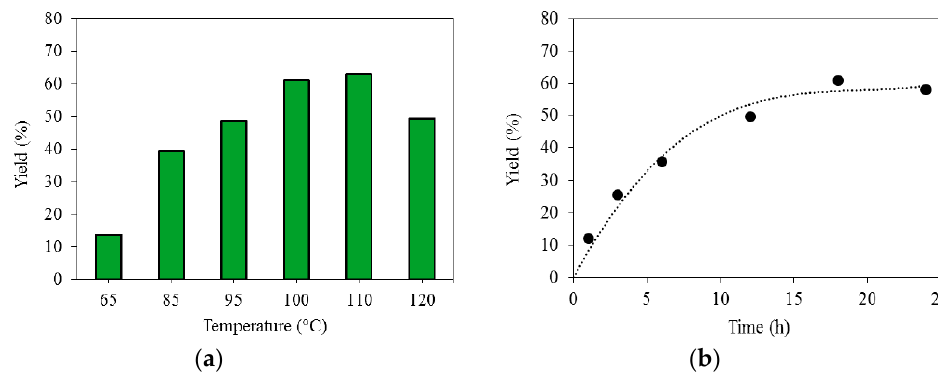
Figure 2. Effect of temperature ( a ) and reaction time ( b ) on the yield of 4,4-dimethyl- γ -butyrolactone formed by cyclocarbonylation of 2-methyl-3-buten-2-ol. Reaction conditions: 0.1 M 2-methyl-3-buten-2-ol, 4 mol% Pd(OAc) 2 , 16 mol% DPEphos, 1.0 g [BMIM]Cl, 5 mL DCM, 28 bar (CO/H 2 : 23/5), 18 h ( a ), 100 ° C ( b ).